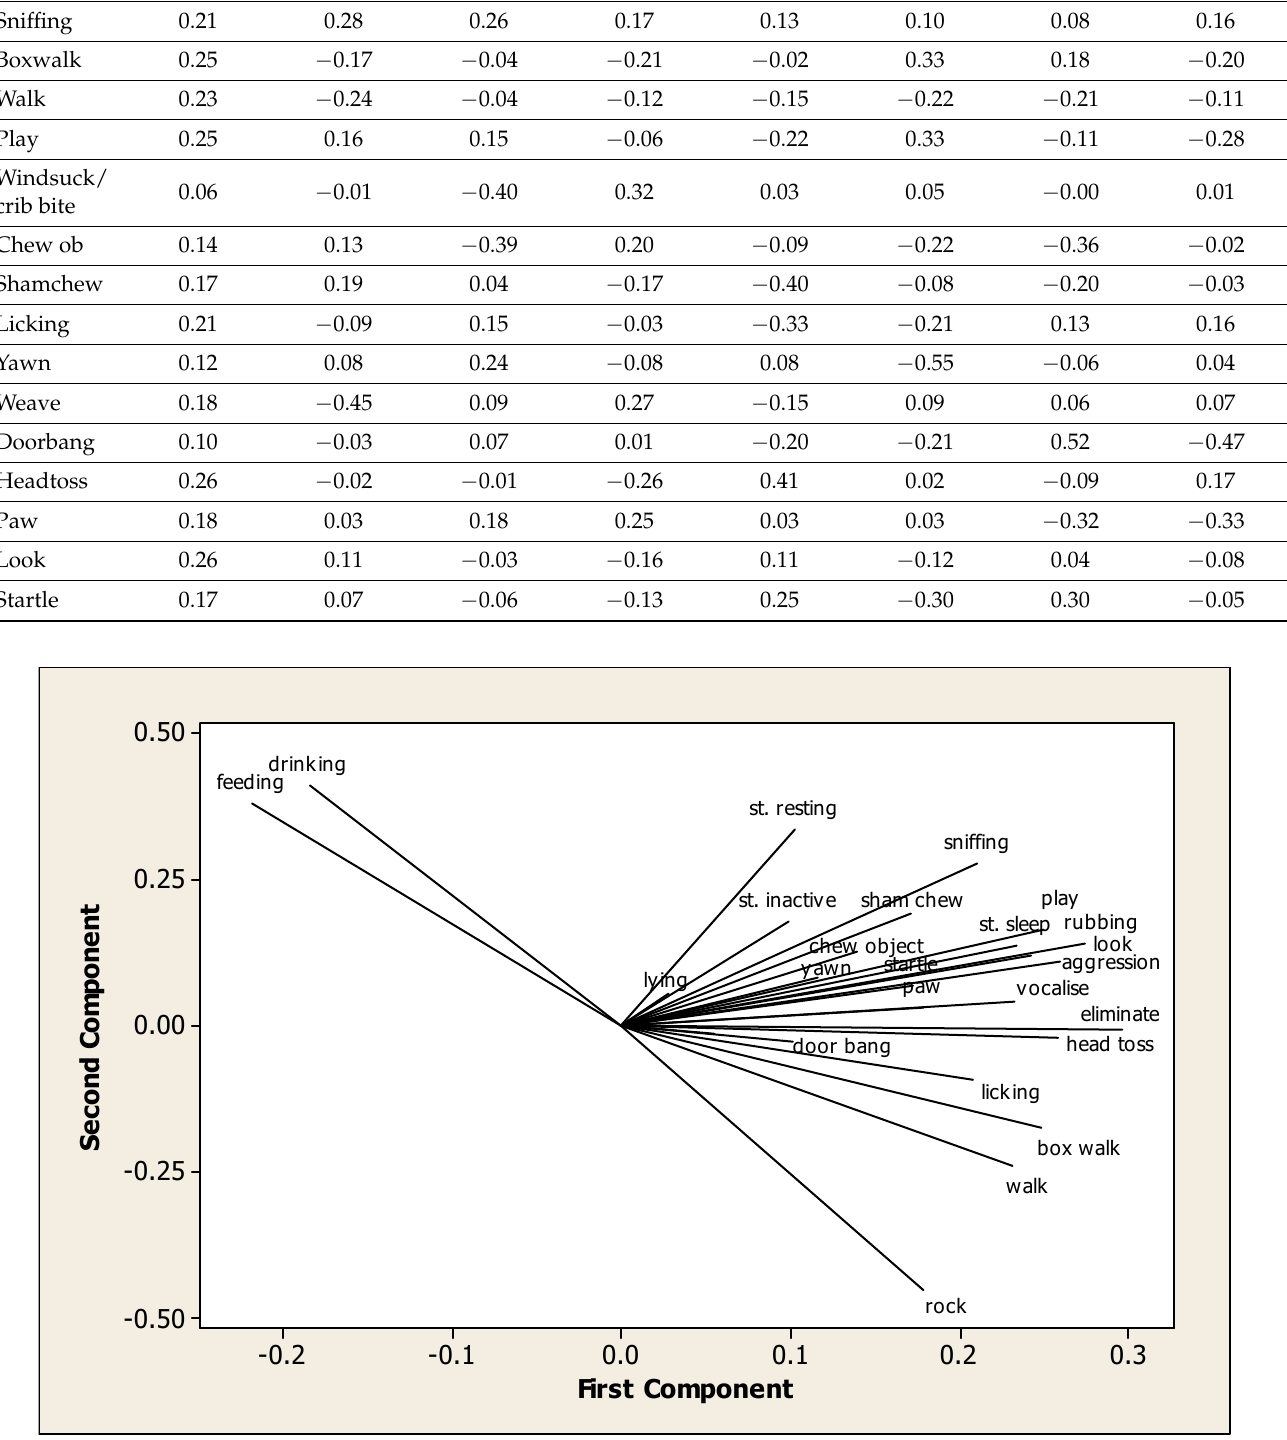
Figure 1. Behaviours in first and second components of principal component analysis. Resting = standing resting; standing = standing sleeping; inactivity = standing inactive . Table 3. Eight principal components (PC) for behaviours of TBRs in stables ( n = 133) .